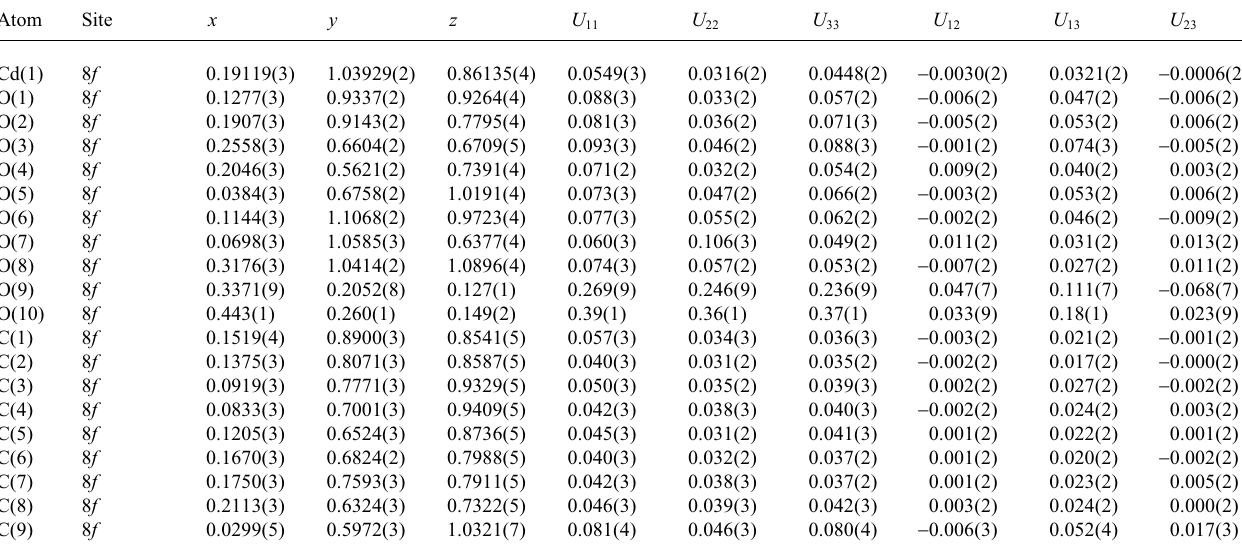
Table 3. Atomic coordinates and displacement parameters (in Å 2